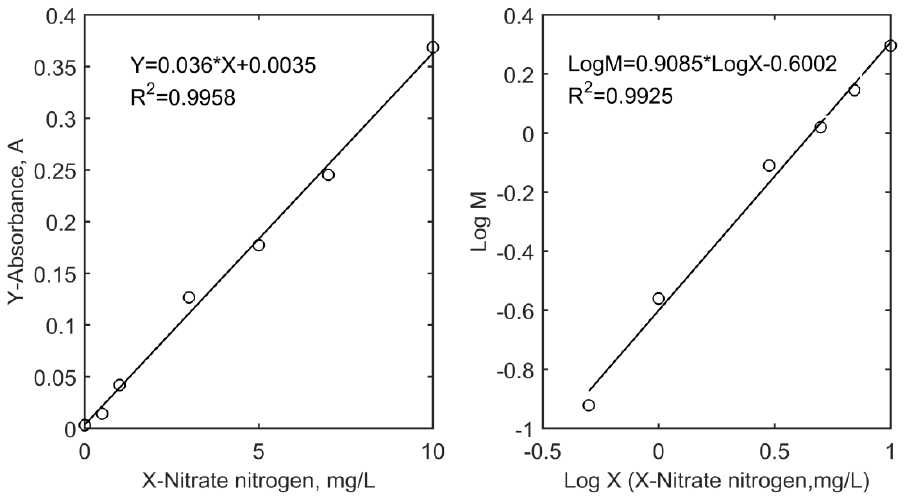
Figure 8. Traditional model curve and new model curve.